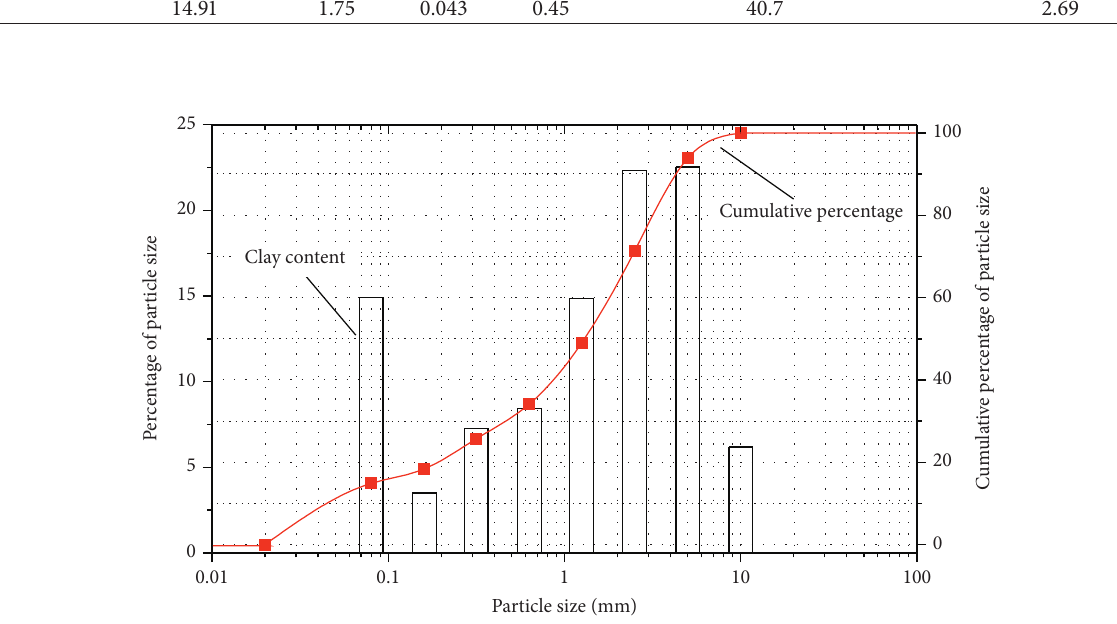
Figure 4: Particle size distribution of clayey sand in Qingdao.